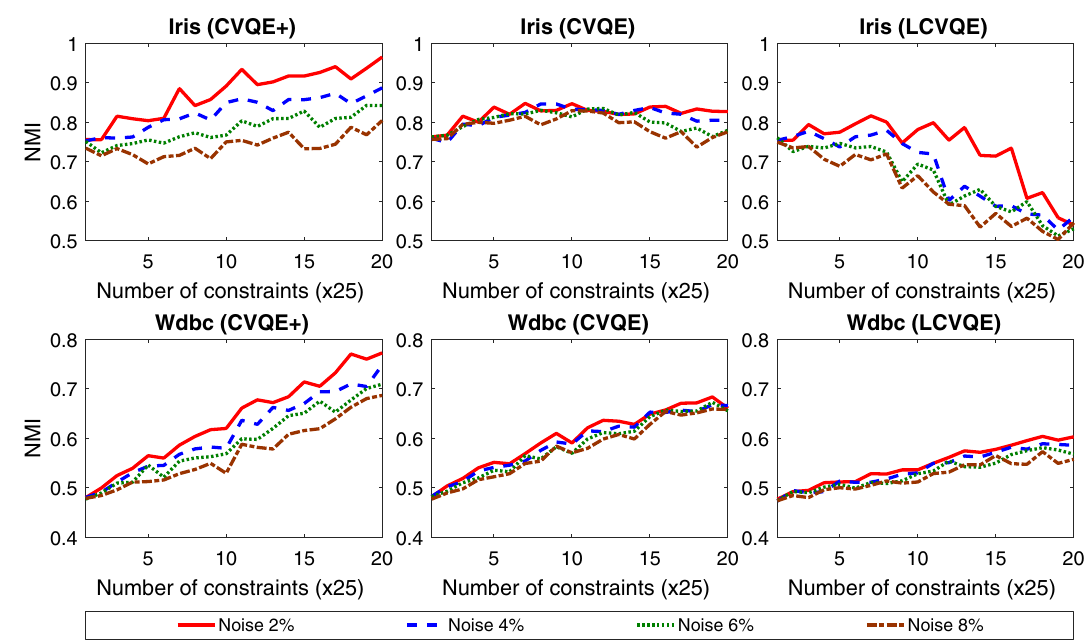
Fig. 6 Effect of noisy constraints on CVQE+ (left), CVQE (middle) and LCVQE (right) for the Iris and Wdbc datasets